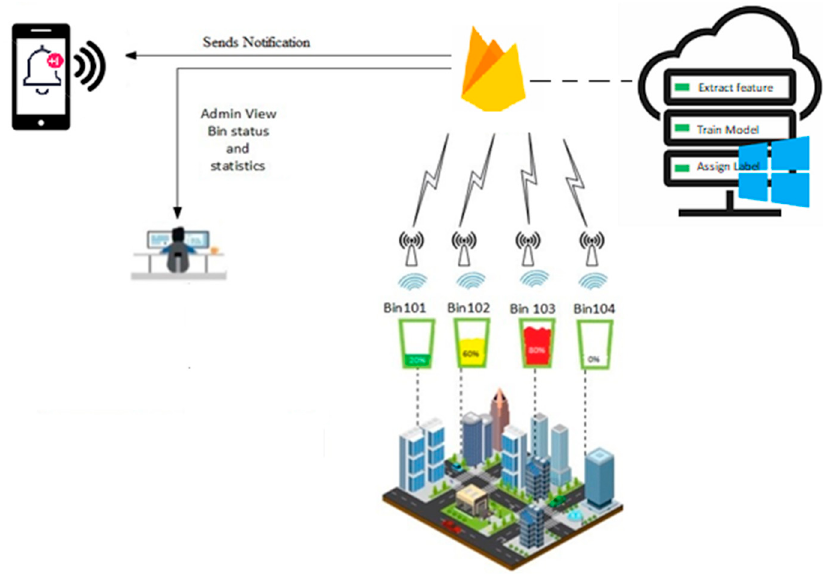
Figure 4. System interaction between different modules.